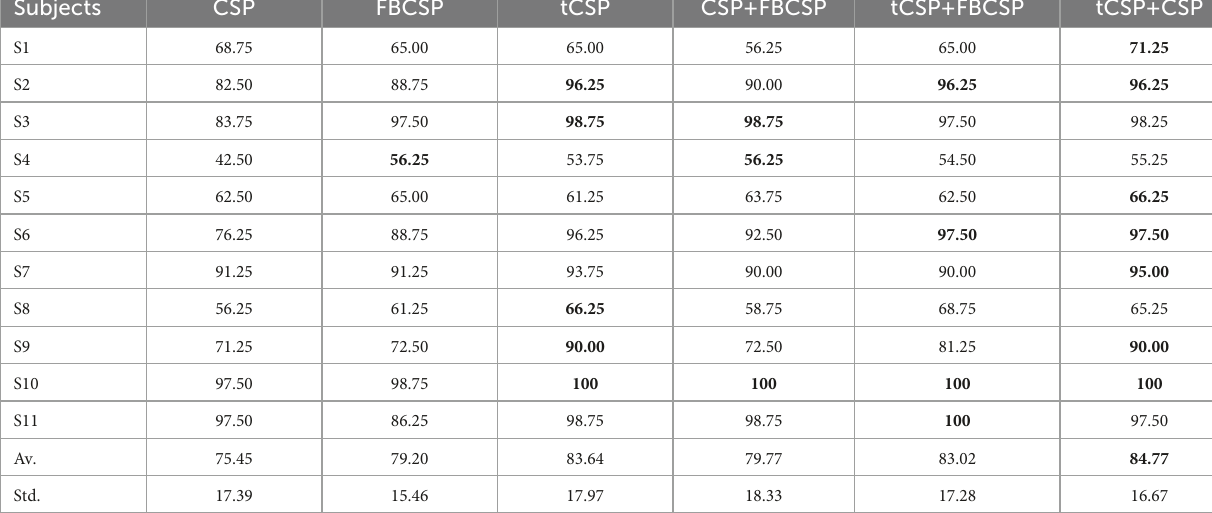
TABLE 2 The classification accuracies (%) of all subjects from experiment one using CSP, FBCSP, tCSP and the combination method.